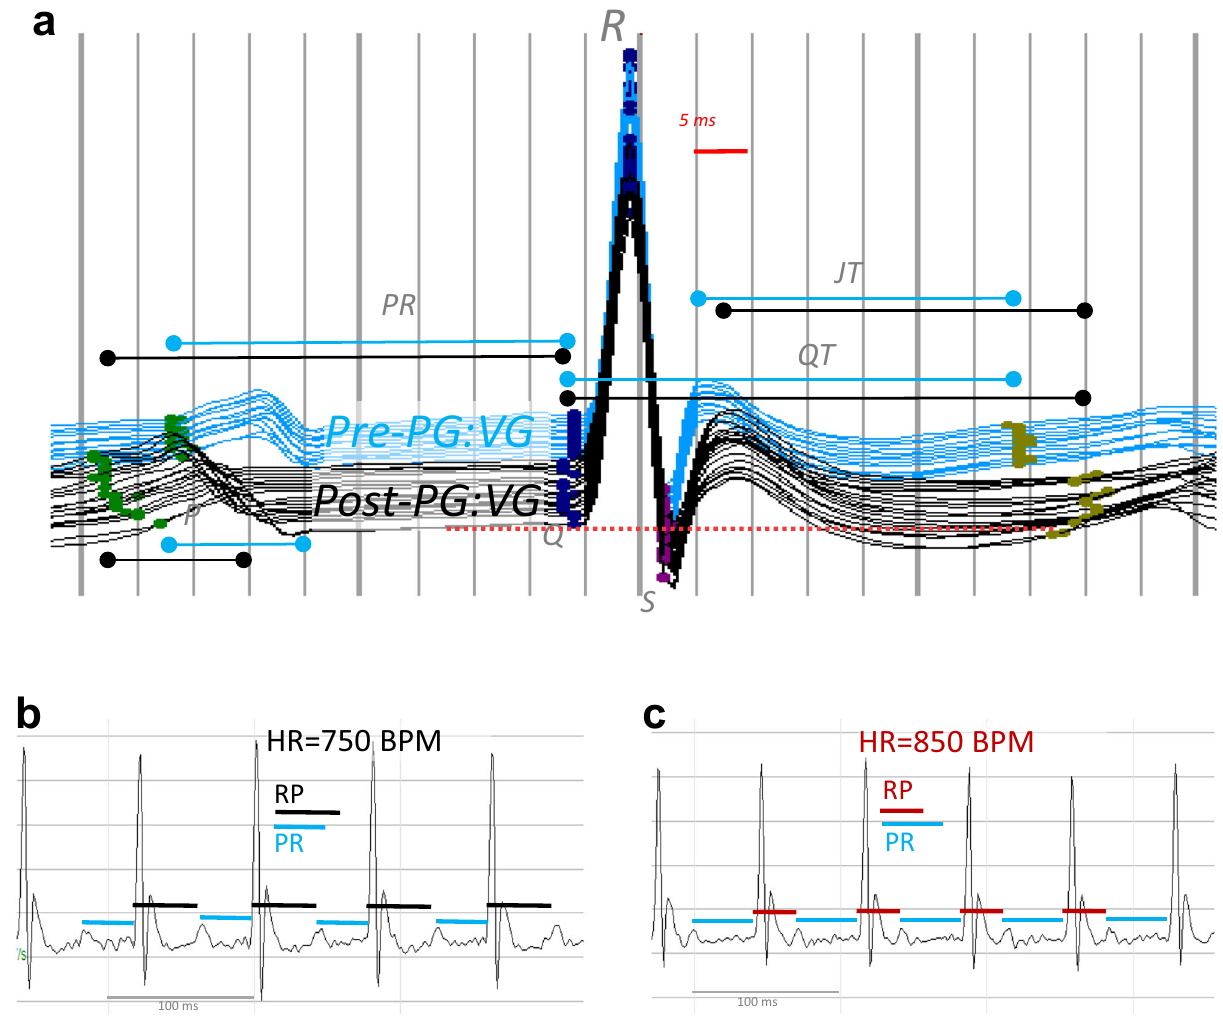
Fig.4|RepresentativeECGwaveformsofE-cigexposedmice.a Waterfallplotof successive1-minaverageECGwaveformsforasinglemouseatpre-exposure(blue) and 4 – 9min after (black) each PG:VG puff session. Horizontal lines indicate approximate mean P duration, PR, QT, and JT intervals for pre- (blue) and post- exposure (black). Waveform dots indicate P-begin (green), Q-begin (navy blue), R